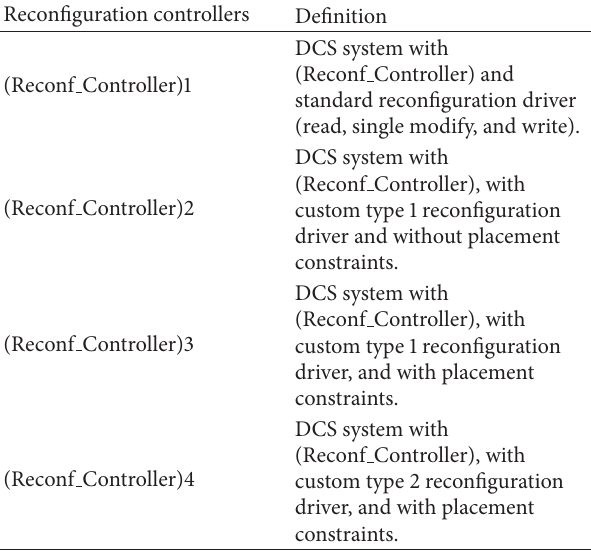
Table 10: Naming convention for reconfiguration controllers.